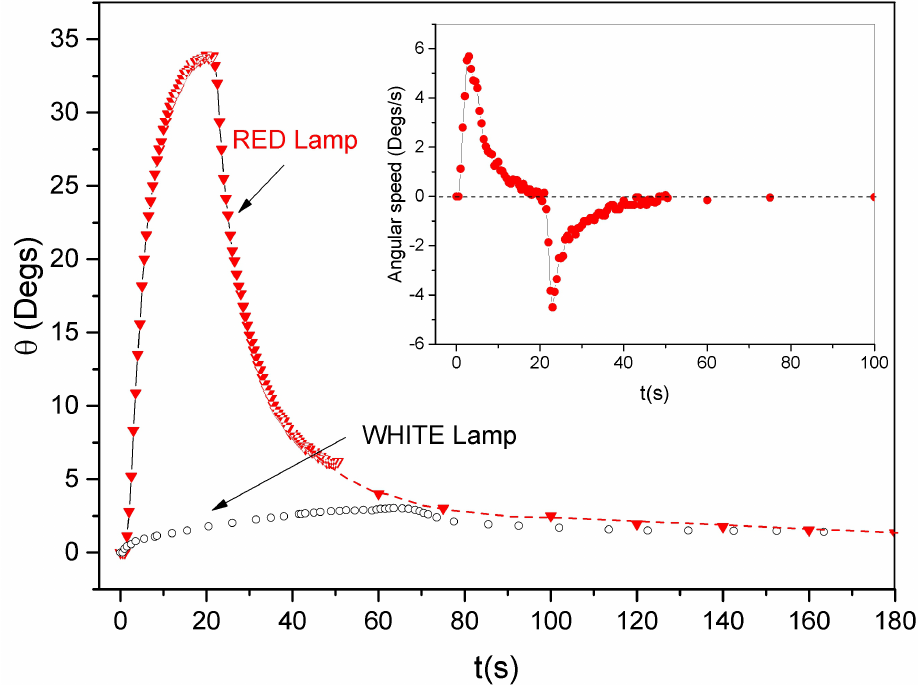
Figure 4. Angular displacement of the film as function of time when incoherent illumination is used. Different sources give completely different results. In the inset is the angular velocity corresponding to the NIR red